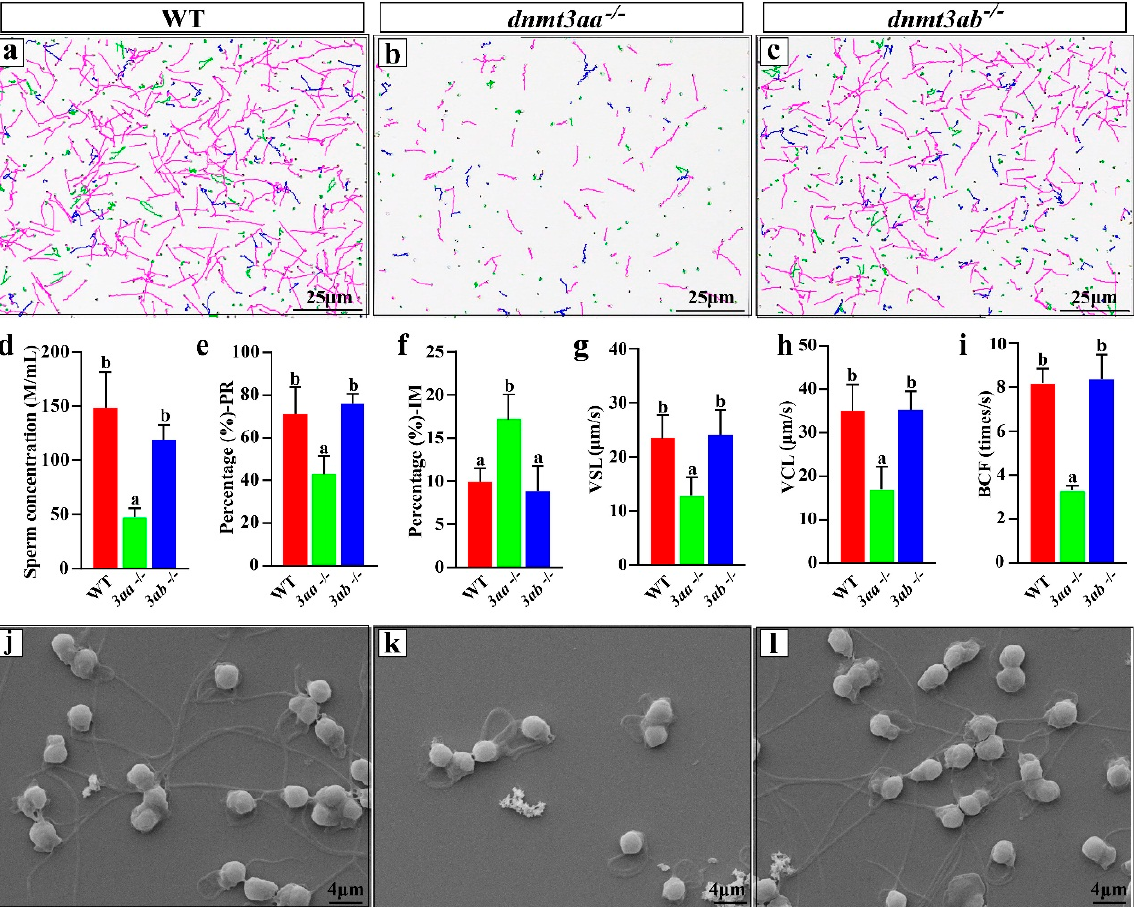
Figure 7. Sperm quality analyses of WT, dnmt3aa − / − and dnmt3ab − / − XY fish at 240 dah. ( a – c ) The tracks of motile sperm from WT, dnmt3aa − / − and dnmt3ab − / − XY fish. Pink, blue and green present grade A, B, C sperm, respectively. ( d – i ) The physiological characteristics of WT, dnmt3aa − / − and dnmt3ab − / − sperm ( n = 5 for each genotype). PR, progressive sperm; IM, immotile sperm; VSL, straight linear velocity; VCL, curvilinear velocity; BCF, beat frequency of sperm flagella. Results are presented as mean ± SD. Different letters above the error bar indicate statistical differences at p < 0.05 as determined by one-way ANOVA followed by Tukey’s post hoc test. ( j – l ) Sperm morphology examination by scanning electron microscope.